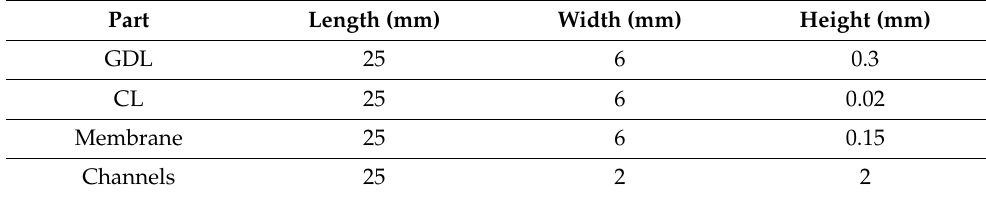
Table 1. Dimensions of PFMFC